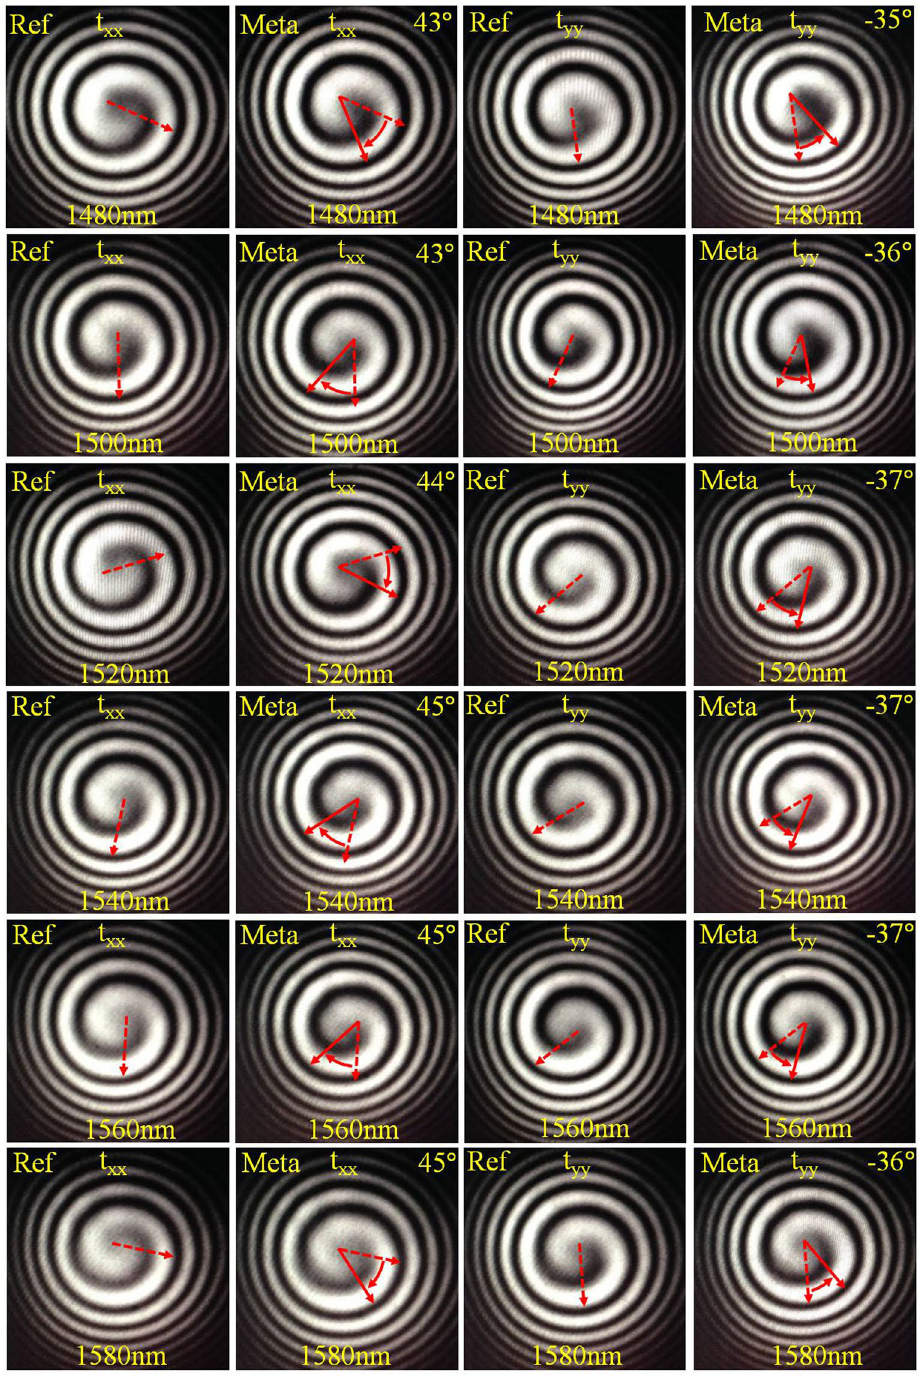
Figure 3. Recorded images of the vortex based spiral interference patterns for optical beam passing through the reference glass substrate (Ref) and the metasurface sample (Meta) under two orthogonal linear polarizations at wavelengths from 1480 nm to 1580 nm with a 20 nm interval. The rotation angles φ xx and φ yy of the spiral interference patterns from the metasurface relative to the reference glass substrate are